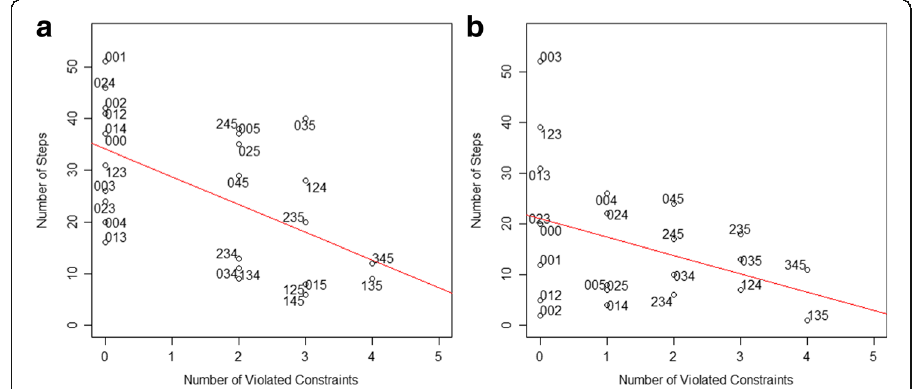
Fig. 8 Plot of correlation between the number of violated constraints and the occurrence frequency of products. a Assignment 10. b Assignment